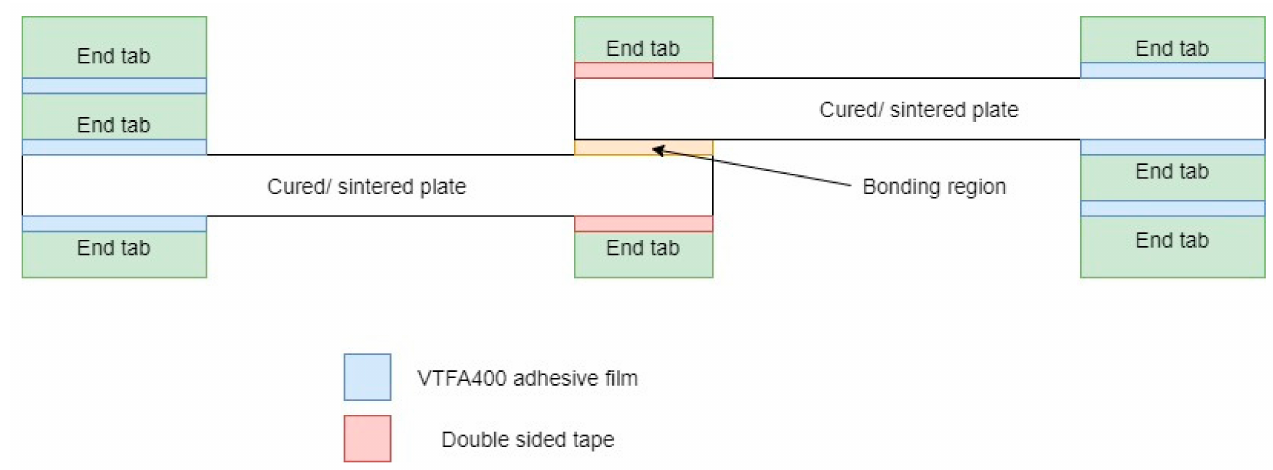
Figure 6. End tab configuration during cutting of the lap shear